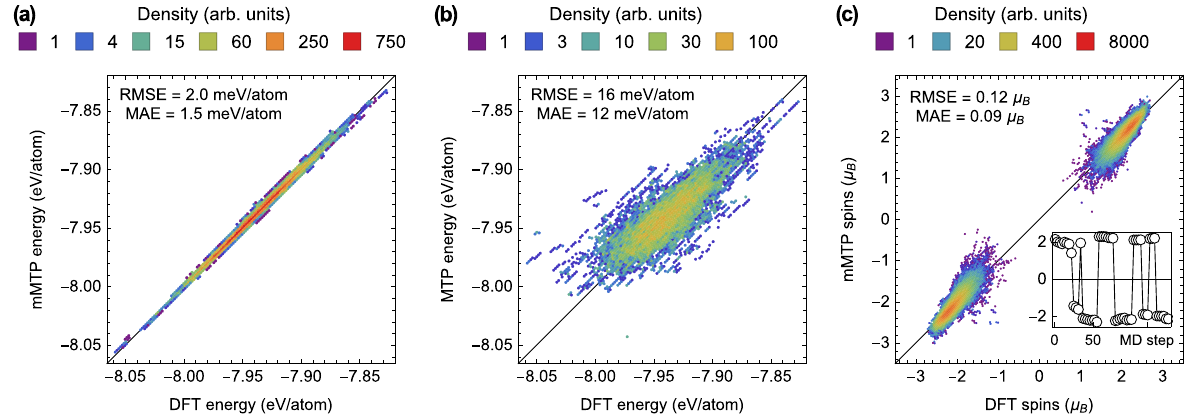
Fig. 3 Energy and spin correlations between different models obtained from DLM-TI calculations at 800 K. It demonstrates that the magnetic MTP predicts both a DFT energies, and c spins with high accuracy, whereas b non-magnetic MTP is almost an order of magnitude worse in